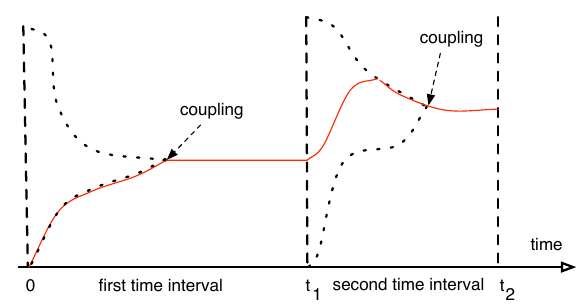
Figure 1: Coupling and stationarity detection. The bounds are plotted in dotted lines while the exact distribution is drawn as a plain red